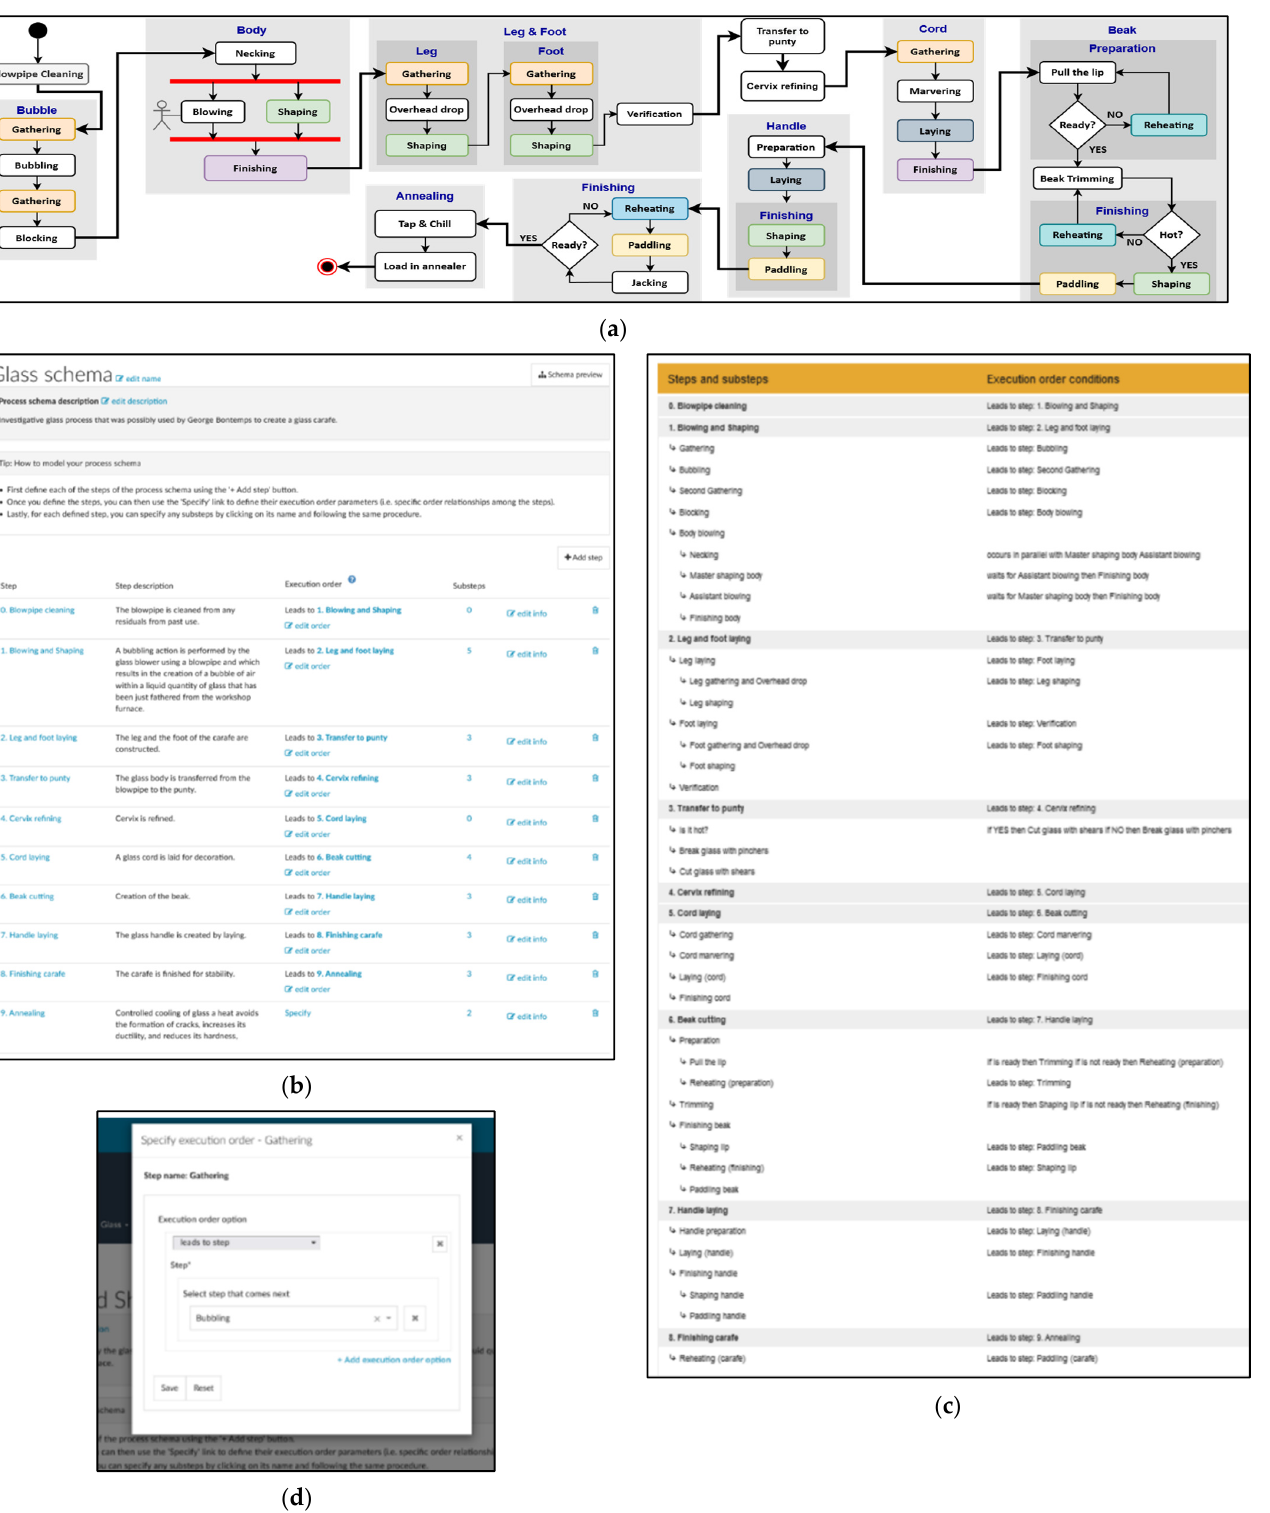
Figure 8. UI components for authoring representations of process schemas and processes. ( a ) Activity diagram representing process schema, ( b ) Data entry form for process schema instantiation, ( c ) Data entry for instantiation of process step, ( d ) Process step presentation.